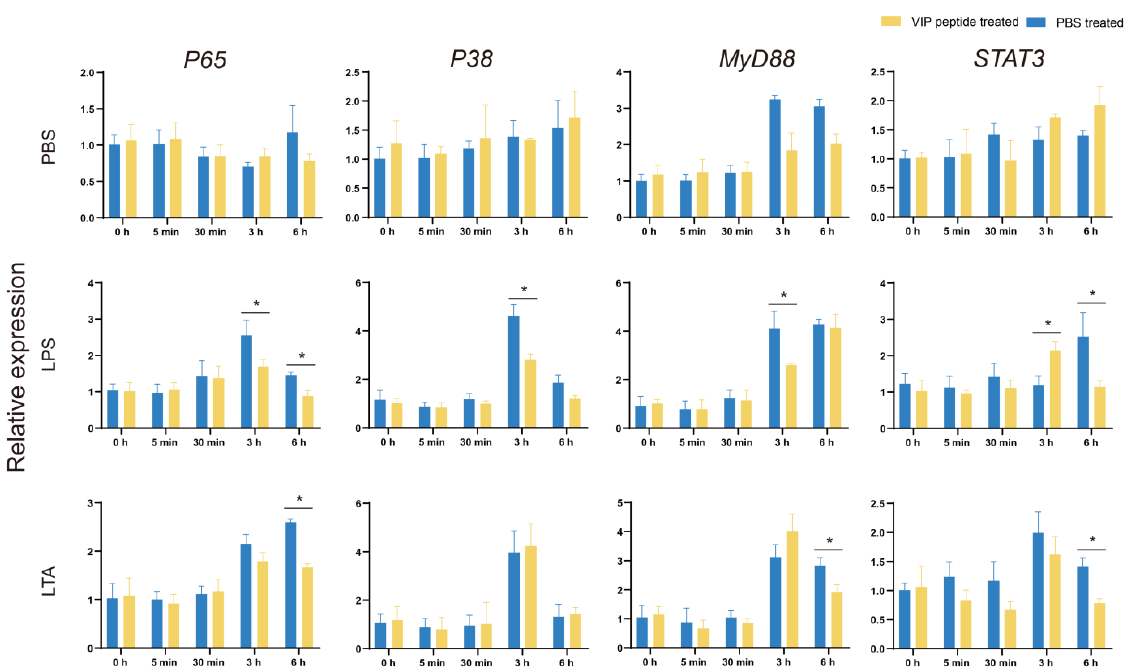
es. Meanwhile, the similar results were observed for P65 , MyD88 , and STAT3 in the LTA + VIP + MO/MΦ group after 6 h of LTA challenges (Figure 5).